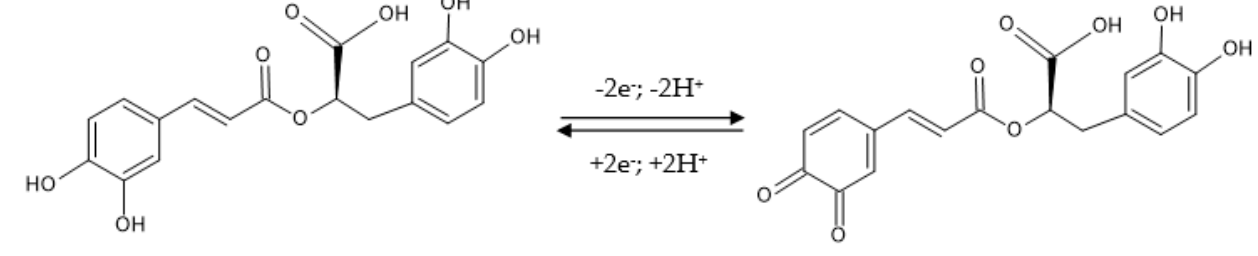
Figure 11. The oxidation mechanism of rosmarinic acid .